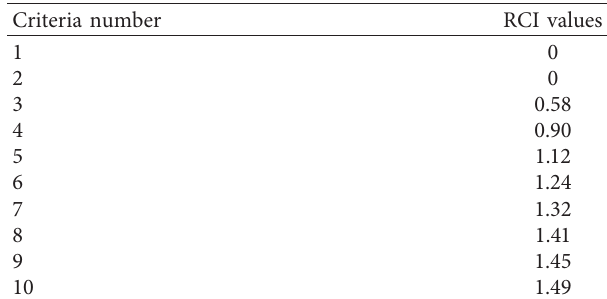
Figure 1: The system model for uplink transmission in HetNet. Table 1: Criteria importance meaning. Table 2: RCI